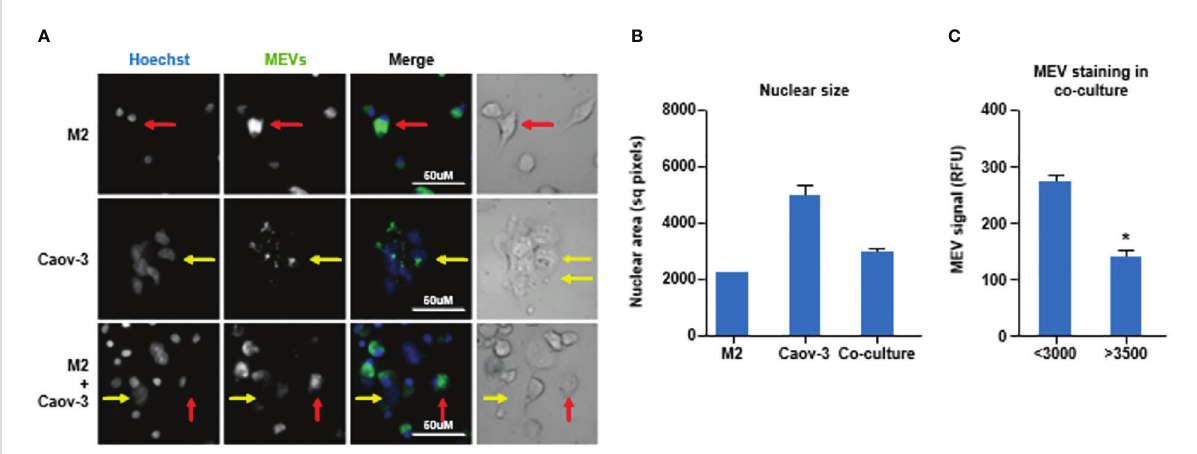
FIGURE 3 (A) Human macrophages display a higher uptake of human M1 MEVs compared to ovarian cancer cells. Confocal imaging of human M2 macrophages alone, Caov-3 cells alone, and co-cultured human M2 macrophages plus Caov-3 cells following a 24-hour incubation with